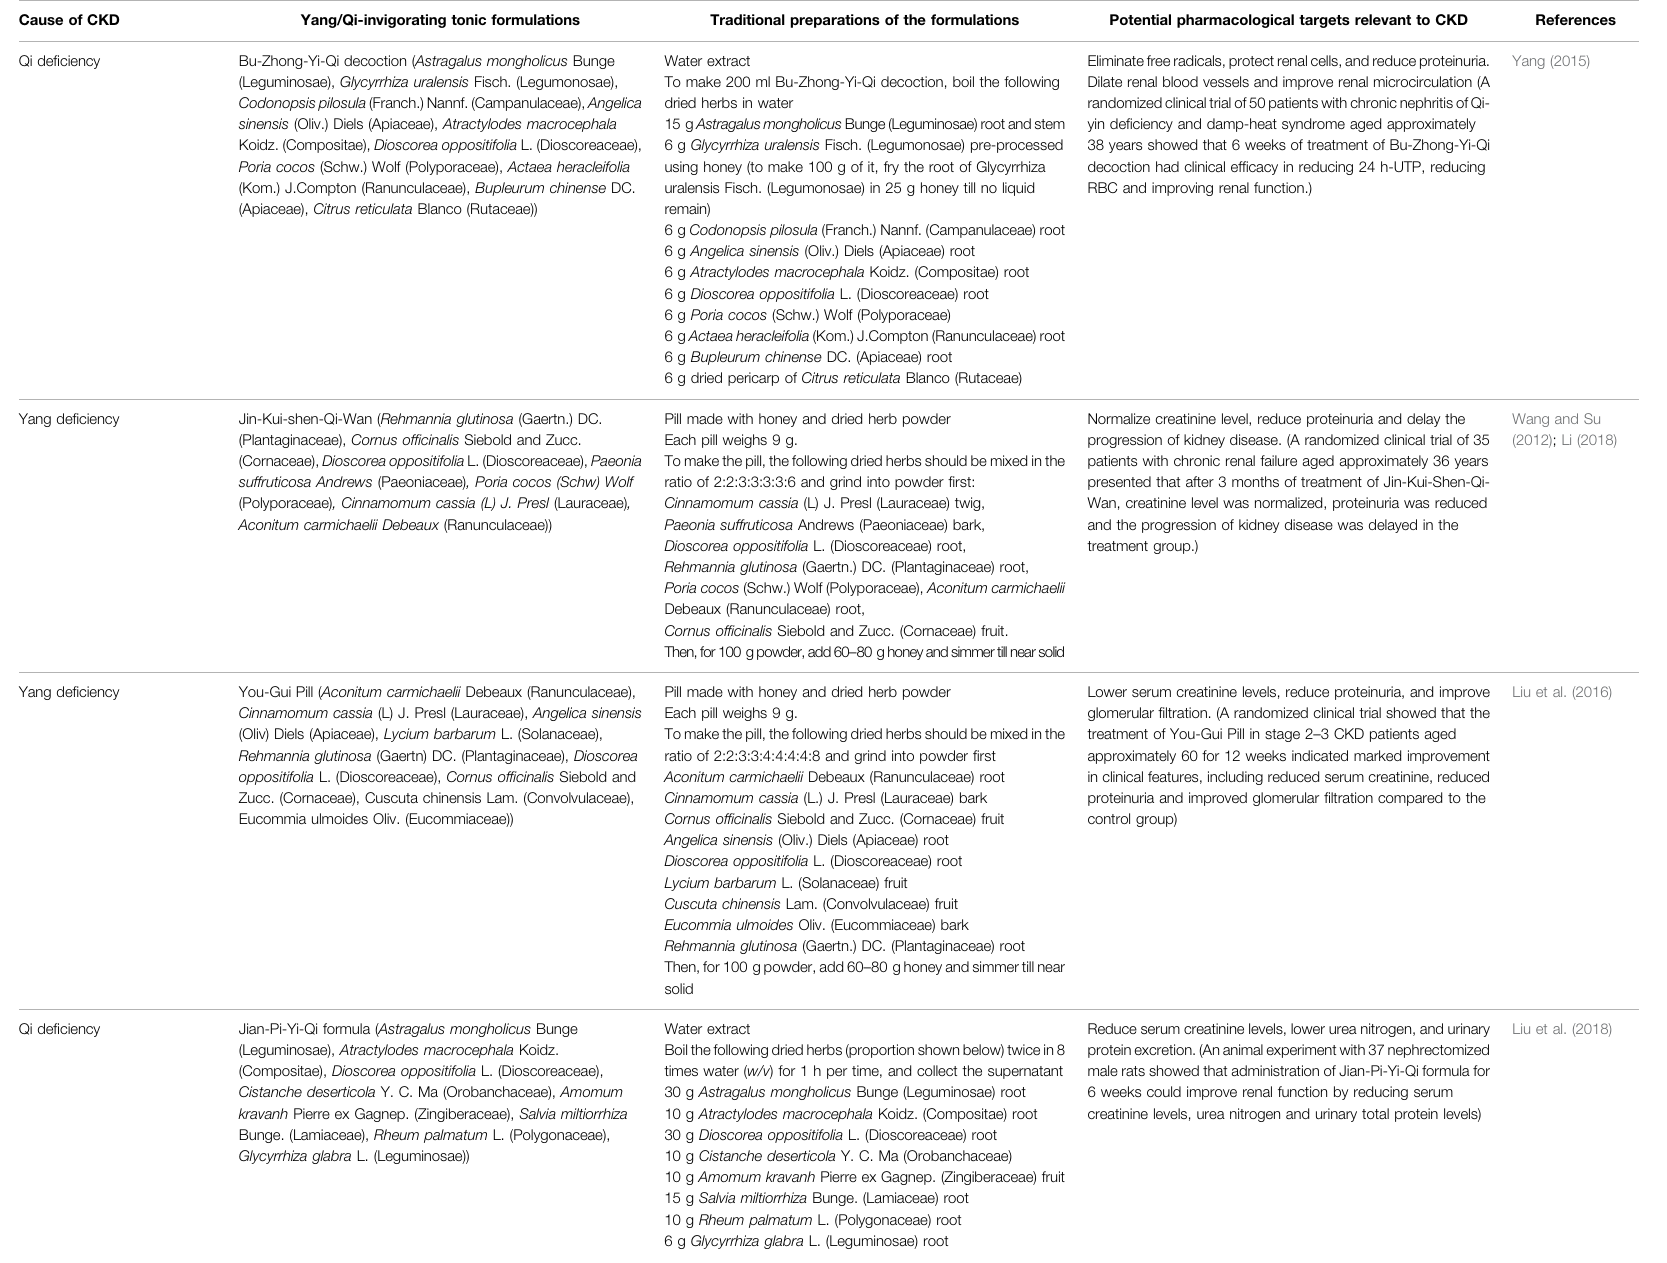
Eliminatefreeradicals,protectrenalcells,andreduceproteinuria. Yang (2015) Dilate renal blood vessels and improve renal microcirculation (A To make 200 ml Bu-Zhong-Yi-Qi decoction, boil the following randomizedclinicaltrialof50patientswithchronicnephritisofQi- yin de fi ciency and damp-heat syndrome aged approximately 38 years showed that 6 weeks of treatment of Bu-Zhong-Yi-Qi decoction had clinical ef fi cacy in reducing 24 h-UTP, reducing RBC and improving renal function.)